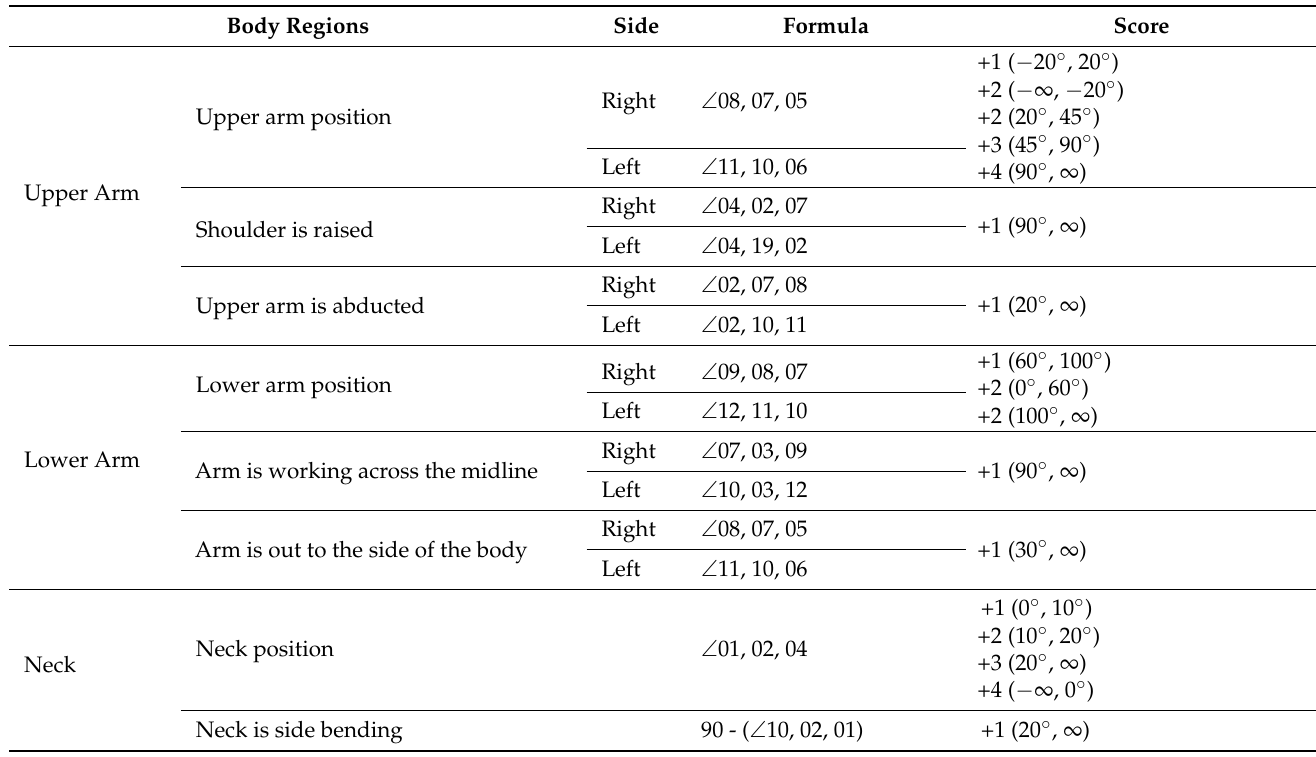
Table 4. RULA body posture score criteria.